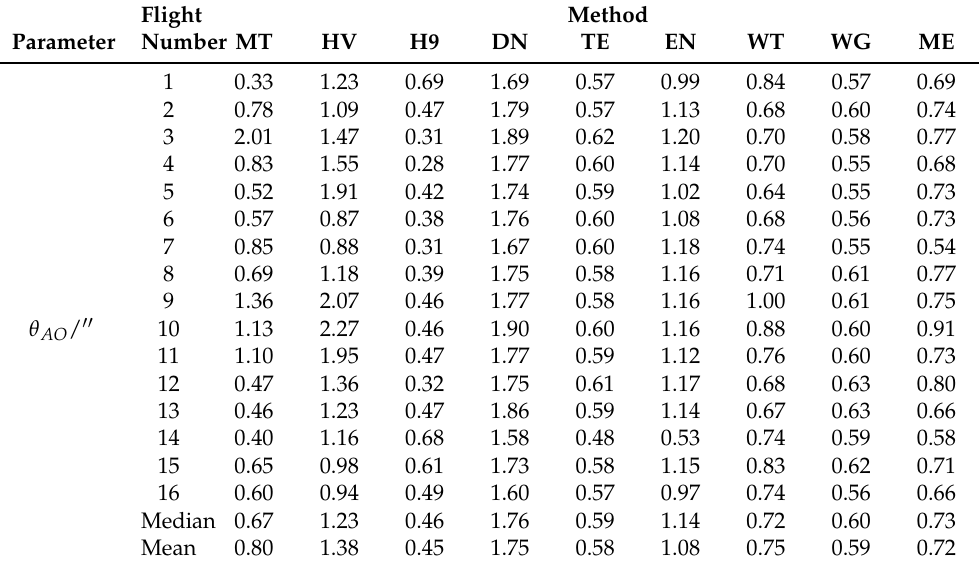
Table A5. ECACN integrated astronomical parameters details ( θ AO @ λ = 550